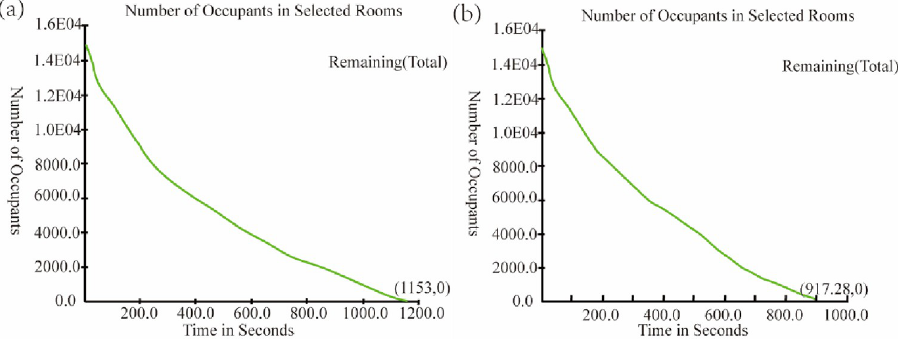
Fig 5. Curves of the total number of people remaining in the evacuation space during evacuation. (a) basic evacuation simulation model, (b) optimized evacuation simulation model.